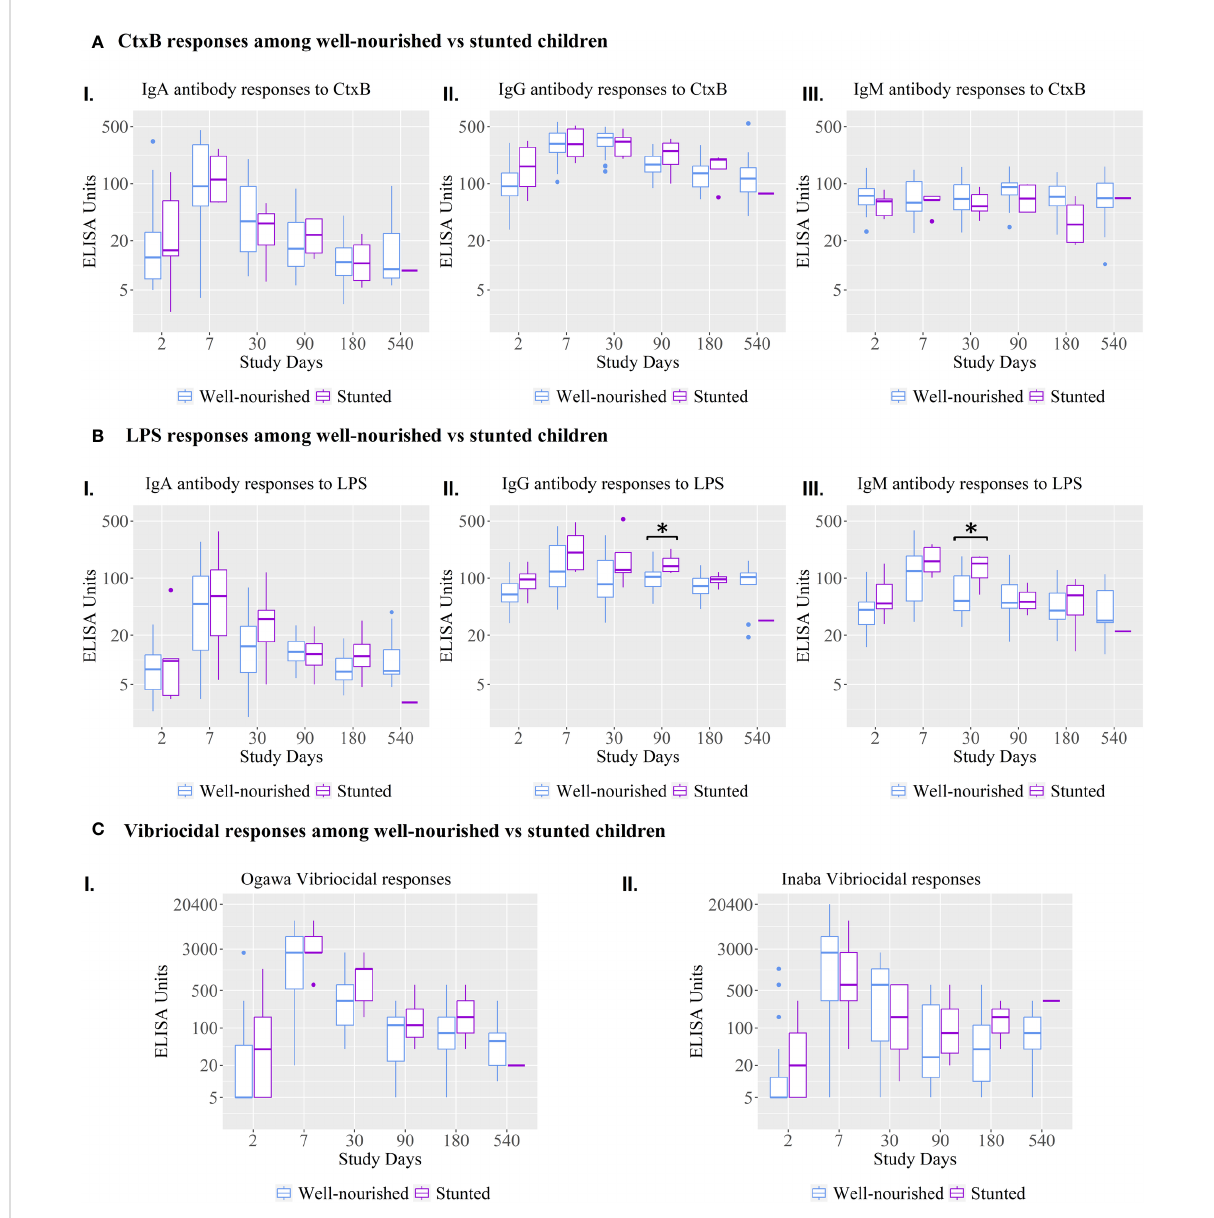
FIGURE 4 Vibriocidal antibody responses and anti-LPS and anti-CtxB IgA, IgG, and IgM immune responses among well-nourished versus stunted children. Kruskal-Wallis test has done in order to identify the signi fi cant difference in median responses of different antibody. Asterisks denote the level of signi fi cance; *p=0.05- 0.01. The black asterisks denote the difference between Well-nourished and Stunted